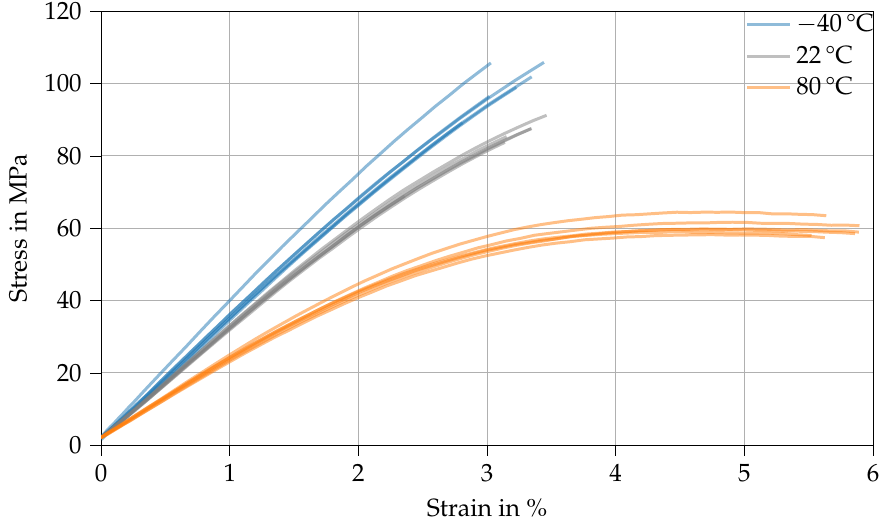
Figure 6. Stress–strain curves derived from three-point bending tests of Argopox at T = − 40°C (blue), 22°C (gray), and 80°C